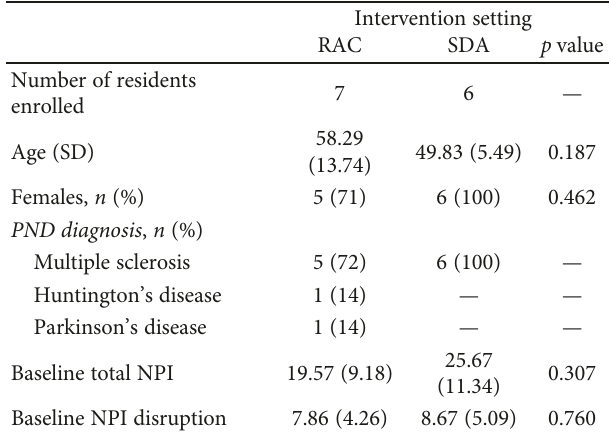
Table 1: Demographic and behavioural data for PND resident